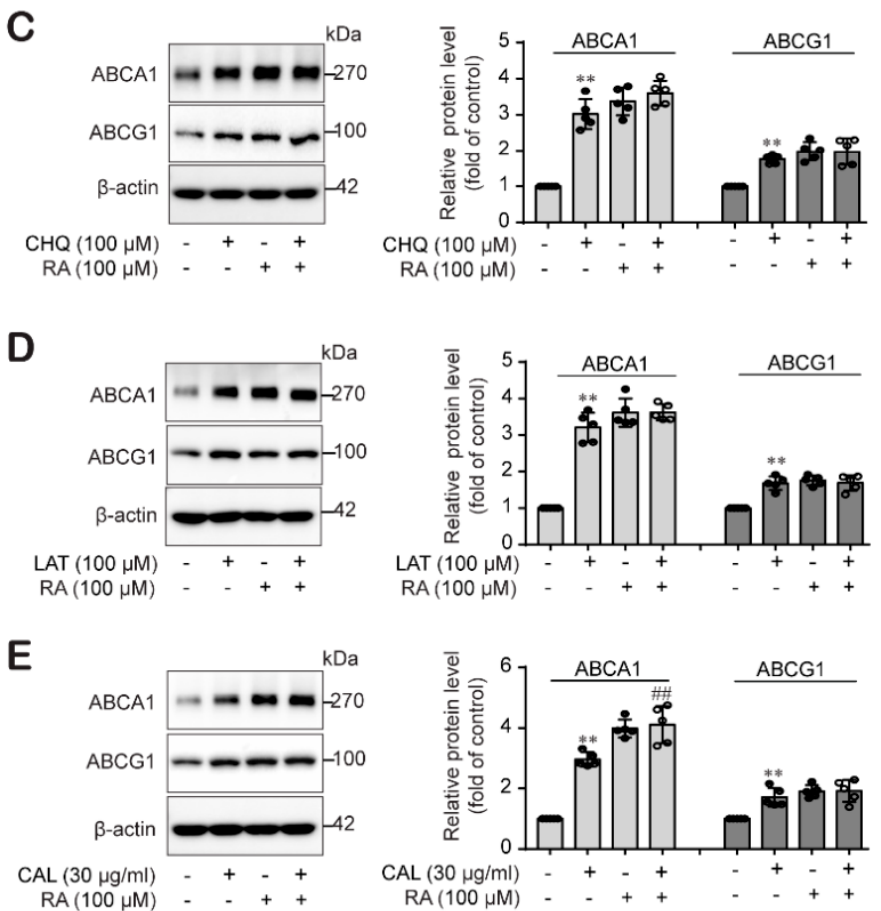
Figure 6. RA stabilizes ABCA1 protein levels by impairing protein degradation. THP-1 macrophages were incubated for 24 h with or without RA (100 μ M) and treated with CHX (140 μ M) for different durations (0, 10, 20, 40 and 180 min). Cell lysates were collected to analyze ABCA1 ( A ) and ABCG1 protein levels ( B ) by western blot analysis. Band densities were quantified, and relative protein levels are presented as the mean ± SD of five independent experiments. Significance is indicated by ** p < 0.01 compared with the control; ## p < 0.01 compared to the CHK-treated group. ( C – E ) Cells were treated with or without RA at 100 μ M for 24 h and incubated for another 3 h with the lysosomal inhibitor chloroquine (CHQ, 100 μ M) ( C ), the proteasome inhibitor lactacystin (LAT, 10 μ M) ( D ), or the calpain inhibitor calpeptin (CAL, 30 μ g/mL) ( E ). Cell lysates were collected for ABCA1 and ABCG1 protein analysis using western blot analysis. Band densities were quan- tified, and relative protein levels are presented as the mean ± SD of five independent experiments. ** p < 0.01 compared to the control; ## p < 0.01 compared to the CAL-treated group.